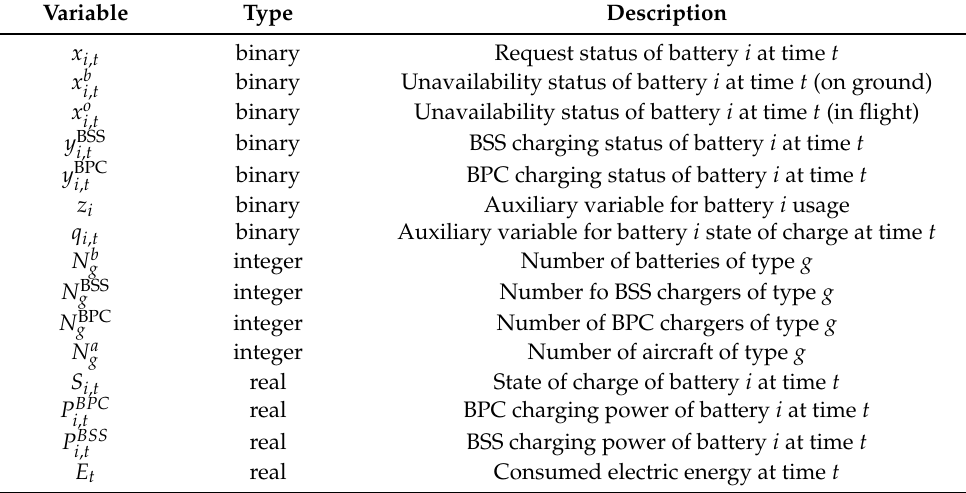
Table 2. ARES optimization variables.